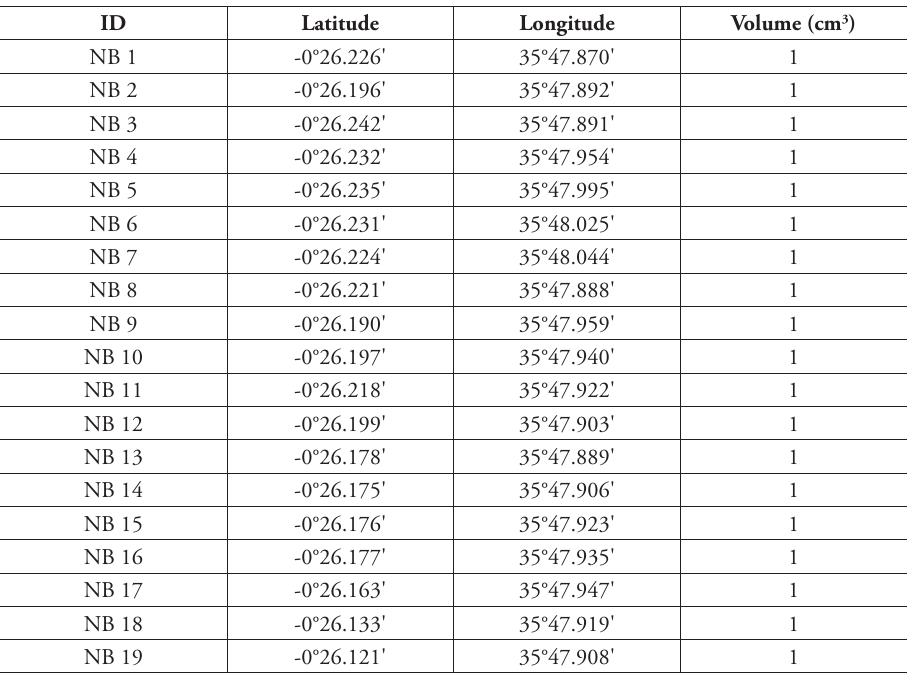
Table 2. Surface sediment sampling locations and volume of wet sediment analysed for L. capensis remains.